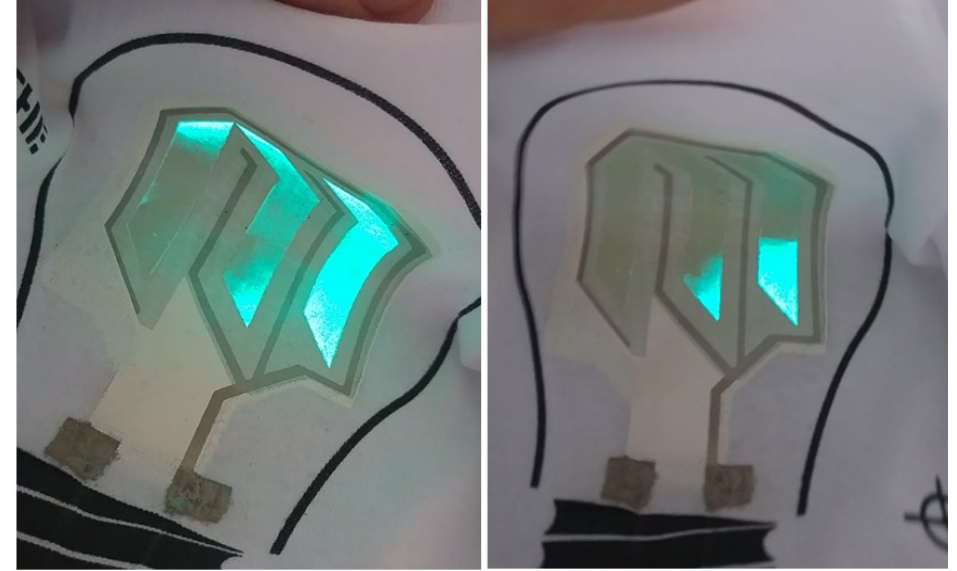
Figure 4. Visible degradation of two exemplary electroluminescent structures with an ATO-based electrode after first wash.